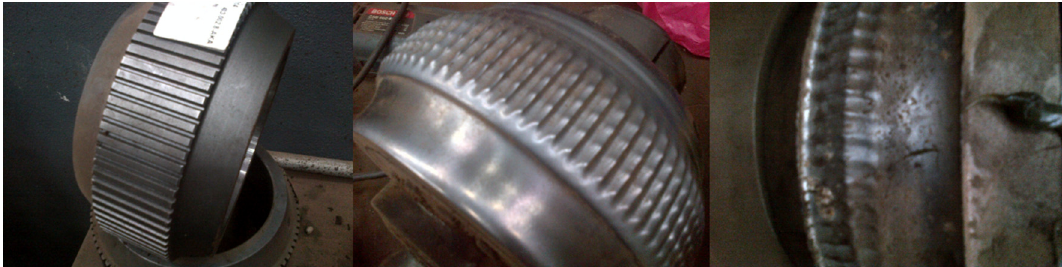
Figure 9. Left: the appearance of a new layer of a pelletizer roll. Center: the wear caused on the cover of a pelletizer roll after 200 h in the production of conventional biomass pellets. Right: the wear caused on the cover of a pelletizer roller after 50 h of processing torrefied biomass.